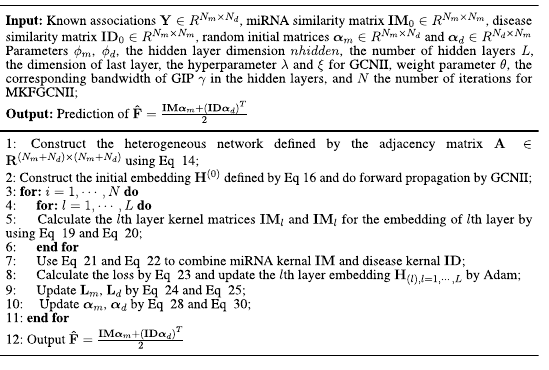
TABLE 1 Algorithm 1 Algorithm of our proposed